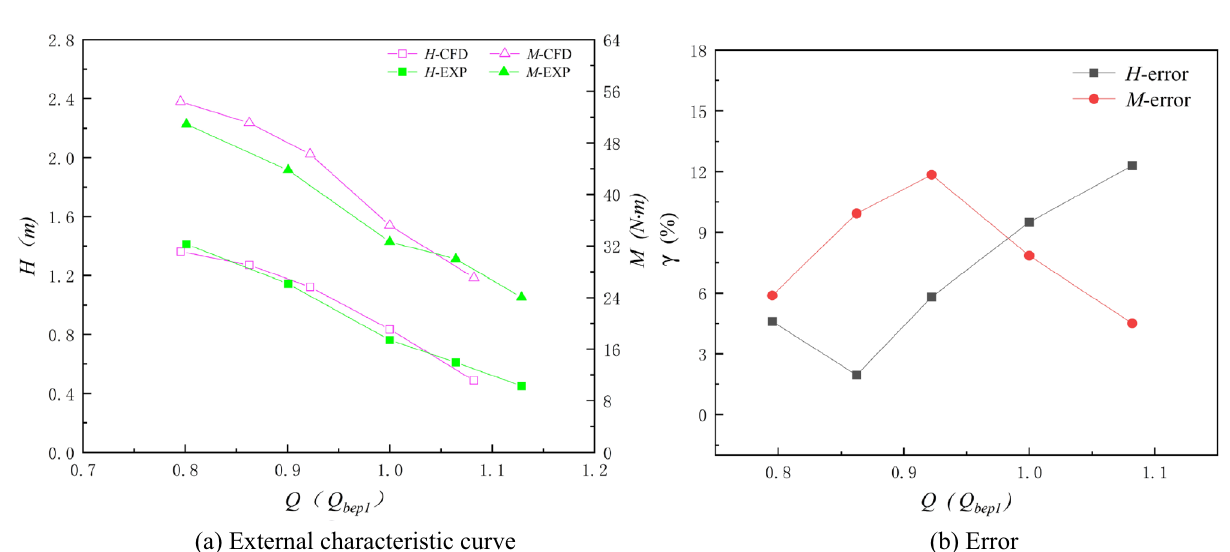
Figure 21. Comparison of numerical simulation results and experimental results of the